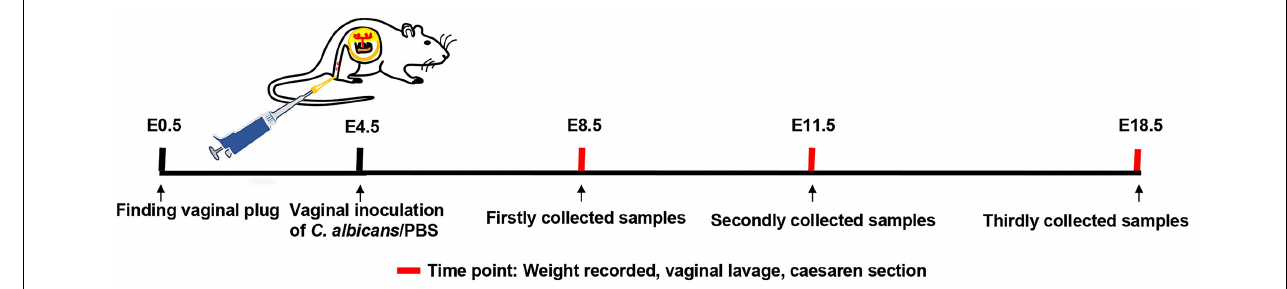
FIGURE 1 | Establishment of a model of vaginal infection with C. albicans . Male and female mice were mated, and the day of finding a vaginal plug was considered as embryonic day 0.5 (E0.5). Pregnant mice received C. albicans (the VVC group) or PBS (the control group) via vaginal inoculation at E4.5. Then, the weight of mice was recorded, and vaginal flush was carried out at E8.5, E11.5, and E18.5, respectively. Finally, the required tissues were collected by cesarean section at the same